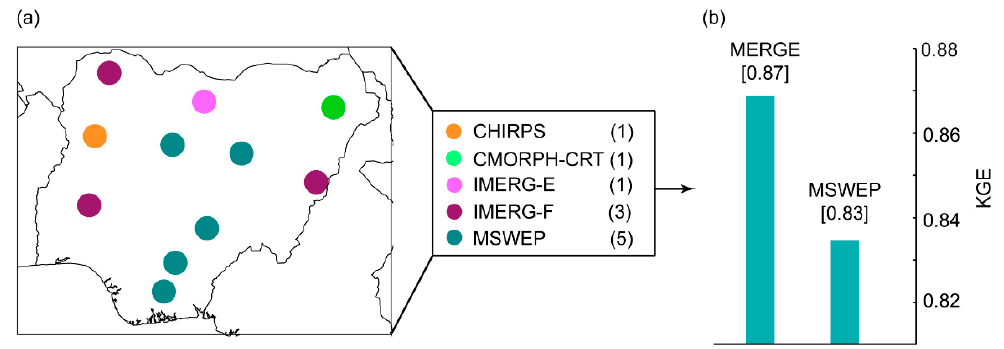
Figure 10. ( a ) Merging of the best product to each location’s result revealed that MSWEP performed better in 5 out of 11 locations, ( b ) cumulative overall KGE score of MSWEP v.2.2 against the best performing products in other location.